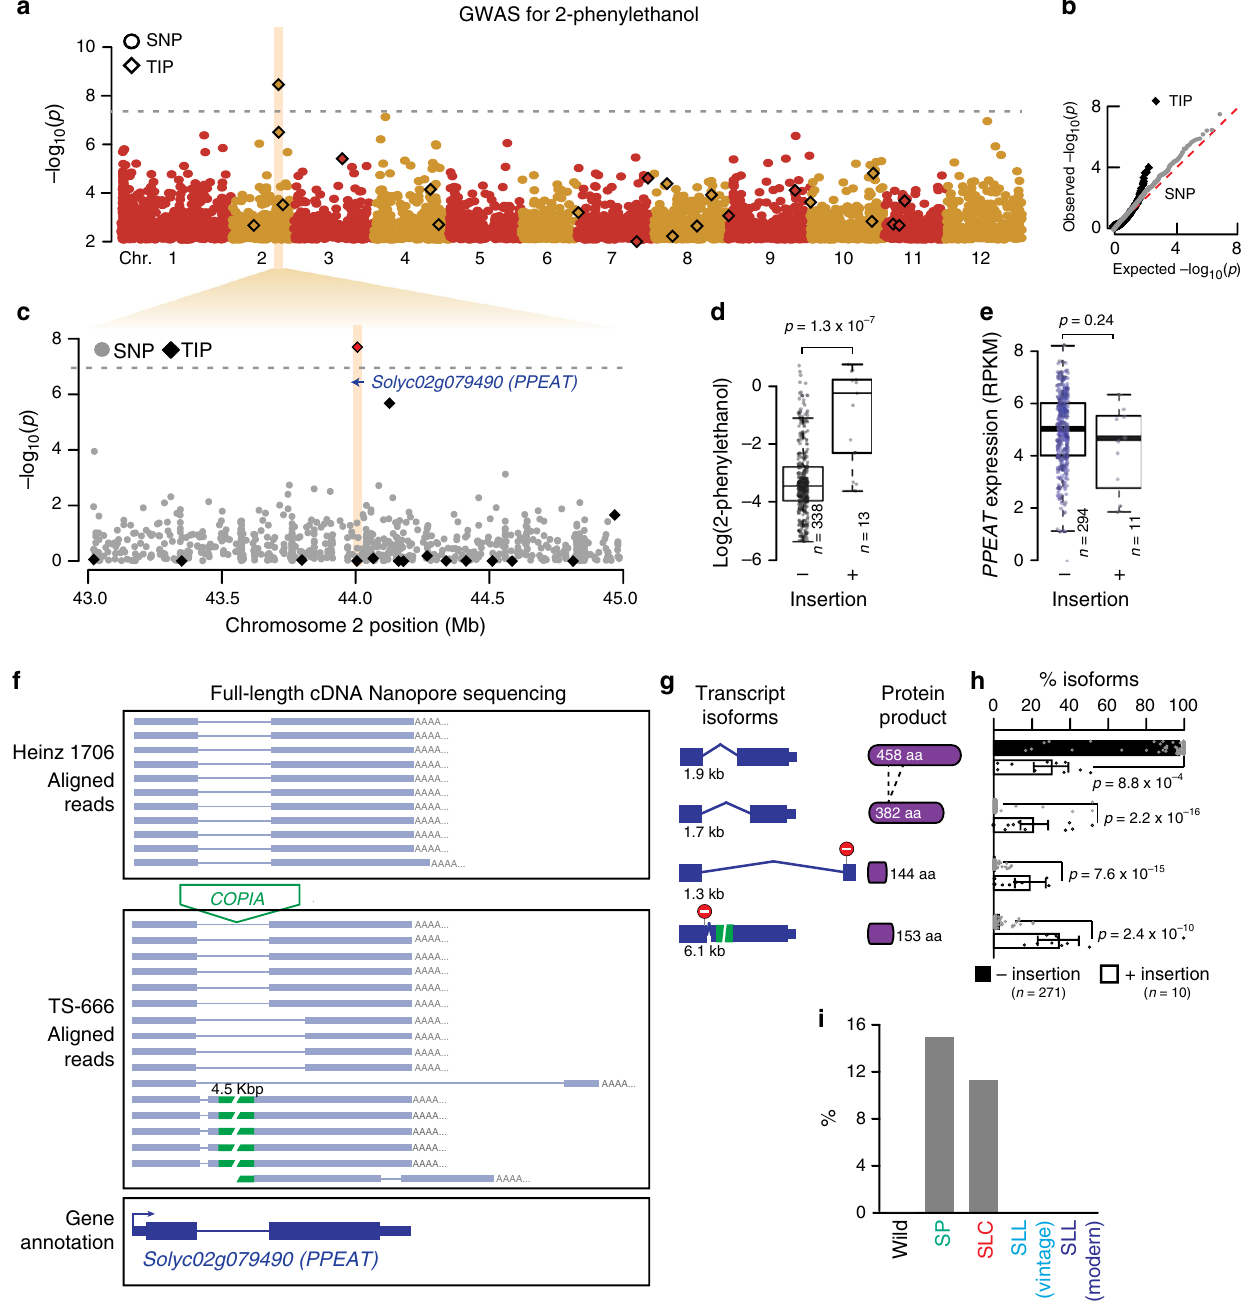
Fig. 5 A key TIP for tomato fl avor. a Manhattan plot of SNP- and TIP-based GWAS (circles and diamonds, respectively) for 2-phenylethanol. b qq-plot depicting observed and expected distribution of p values for SNP- and TIP-GWAS (gray circles and black diamonds, respectively). c Detailed view of the Manhattan plot for 2-phenylethanol spanning Solyc02g079490 (PPEAT) . d . 2-phenylethanol levels in accessions carrying or not the intronic COPIA insertion. Statistical signi fi cance for differences was obtained using one-sided t test. e . PPEAT expression level in accessions carrying or not the intronic COPIA insertion. Statistical signi fi cance for differences was obtained using two-sided MWU test. f Genome Browser view of full-length cDNA nanopore reads from accessions carrying or not the intronic COPIA insertion. g PPEAT transcript isoforms, protein products, and abundance of transcript isoforms in accessions carrying or not the associated TE insertion. Data are mean ± s.d., and statistical signi fi cance for differences was obtained using two-sided MWU test. h Frequency (%) of the intronic COPIA -containing allele in each of the fi ve tomato groups. PPEAT putative 2-phenylethanol acyl transferase. For each boxplot, the lower and upper bounds of the box indicate the fi rst (Q1) and third (Q3) quartiles, respectively, the center line indicates the median, and the whiskers represent data range, bounded to 1.5 * (Q3 – Q1). Source data of Fig. 5d, e, g, h are provided as a Source Data fi